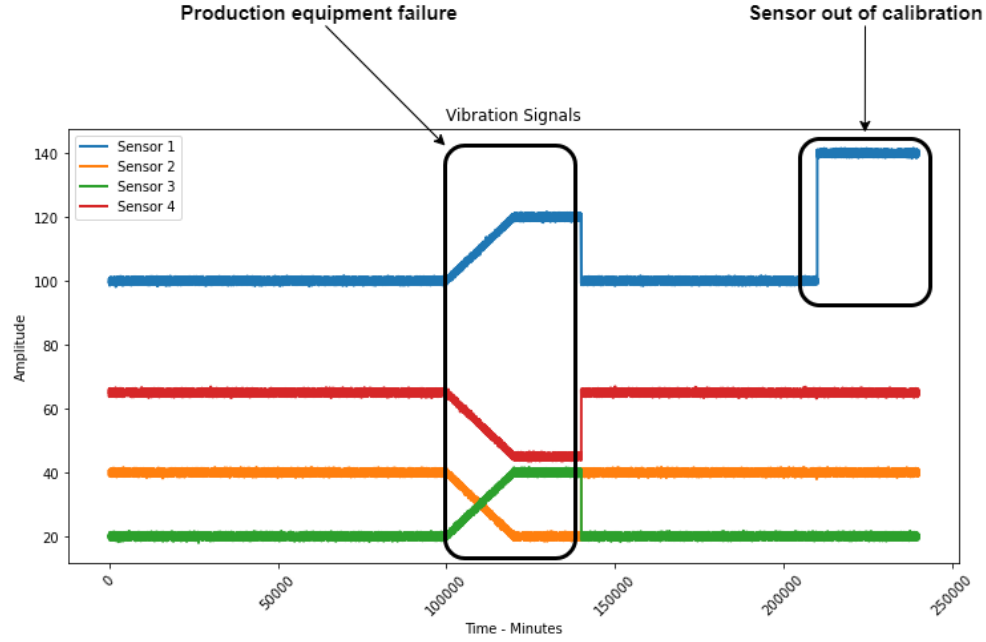
Figure 1. Simulated signal with production equipment error and deviation in one of the